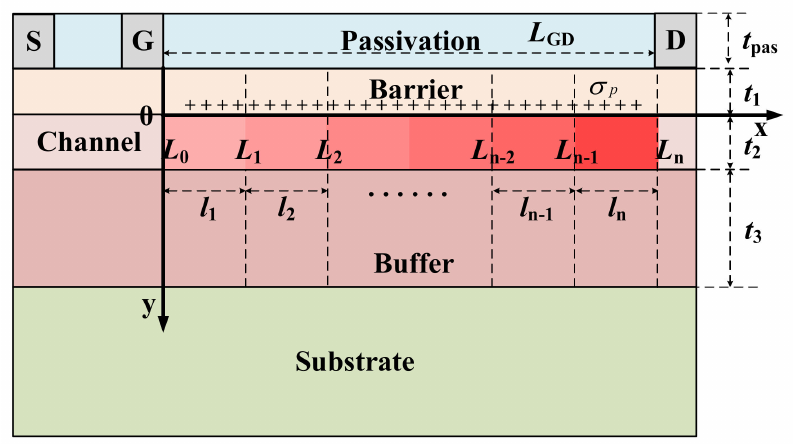
Figure 5. Schematic of the modeling architecture of the n –step SDC–HEMT. The region between gate and drain is fully depleted in